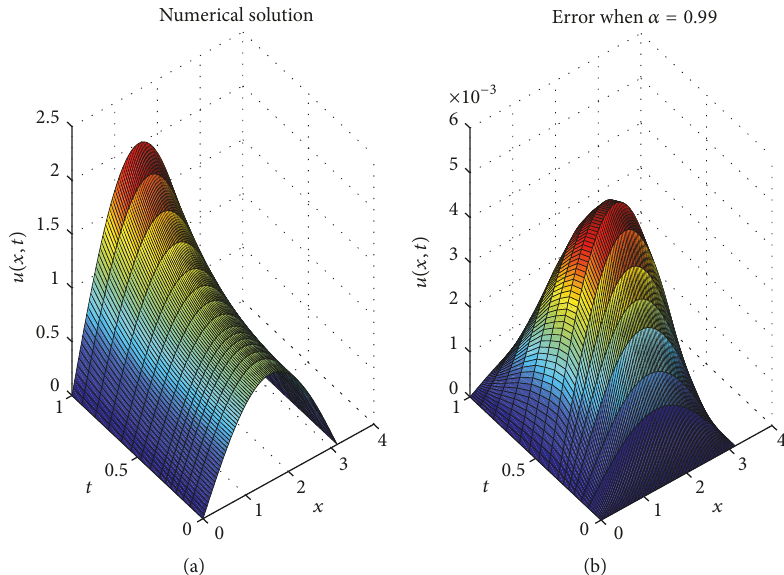
Figure 1: The numerical solution (a) with the error function (b) of Example 4 for 𝛼 = 0.99 over 𝑡 ∈ [0,1].